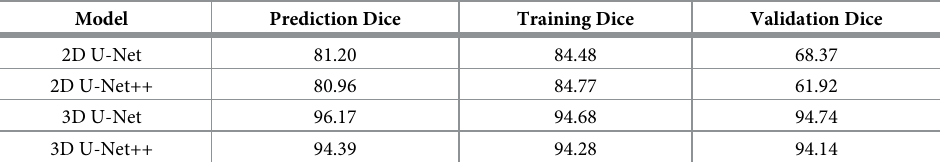
Table 9. 2D and 3D tumor segmentation.